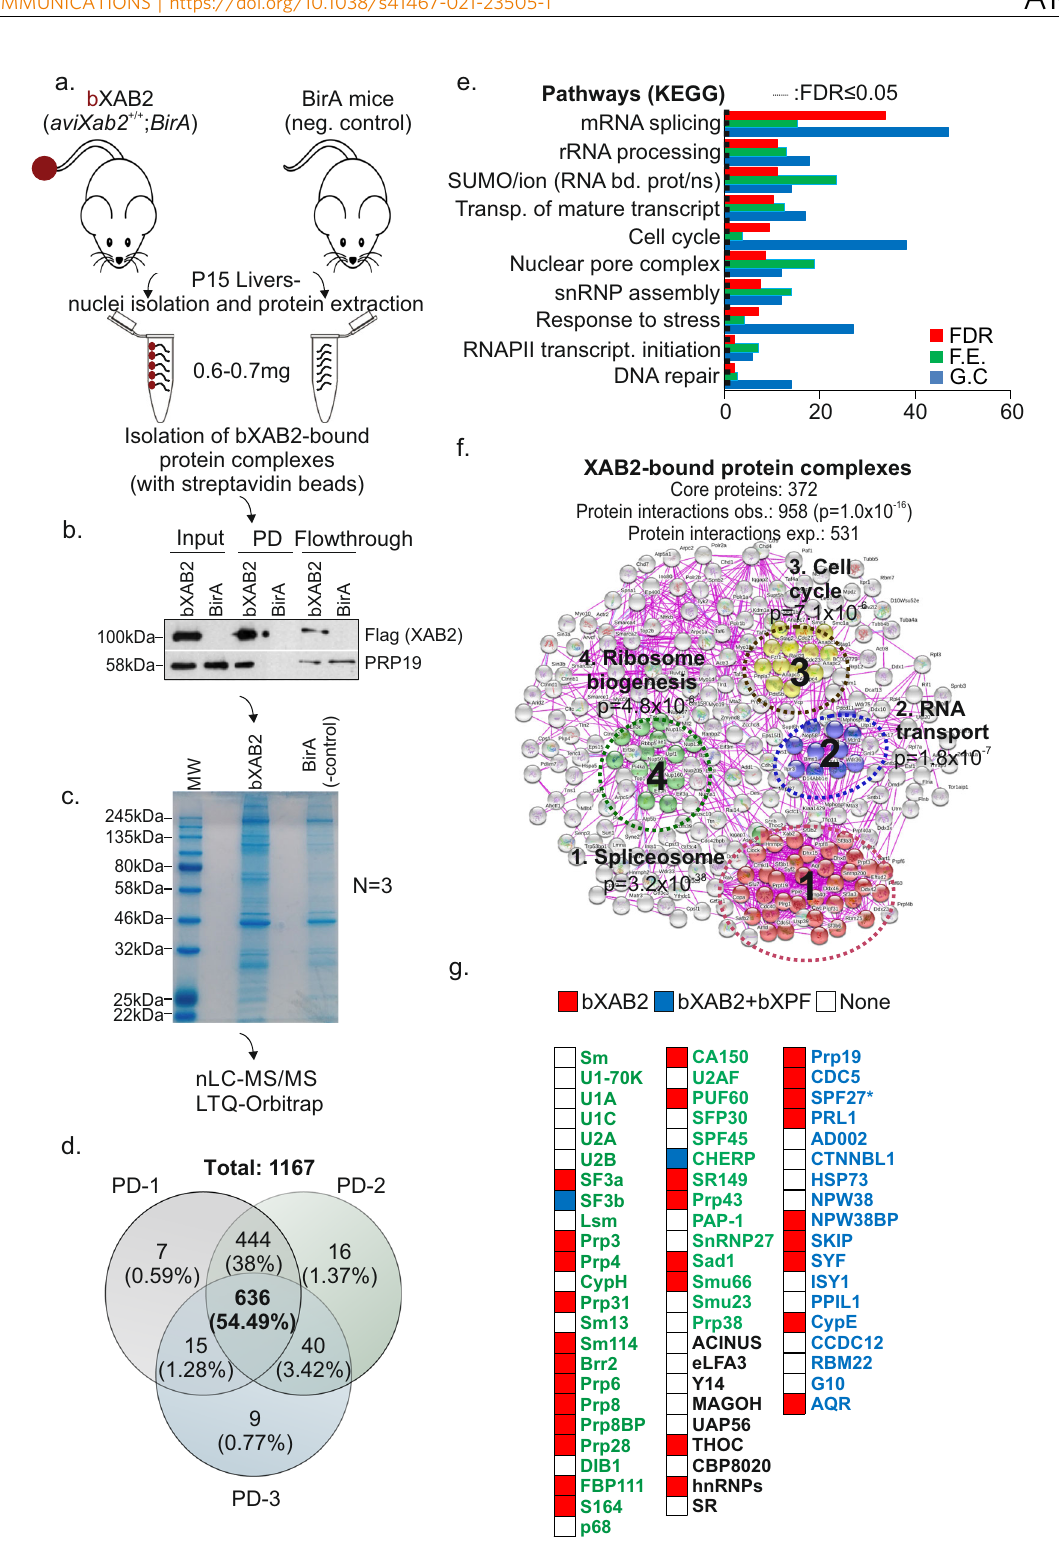
binds directly to UsnRNAs, we performed a series of gel mobility shift assays using a biotinylated RNA oligo that was designed based on the sequence similarities of U4, U5, and U6 snRNAs with the minimal RNA binding sequence of HCF107, a chloroplast-localized protein with repeats of HAT motifs (Fig. S1L). This strategy reveals that the XAB2 IP eluent from nuclear extracts of MEFs consumes the RNA oligo but not its mutant version (Fig. S1M) indicating that the XAB2